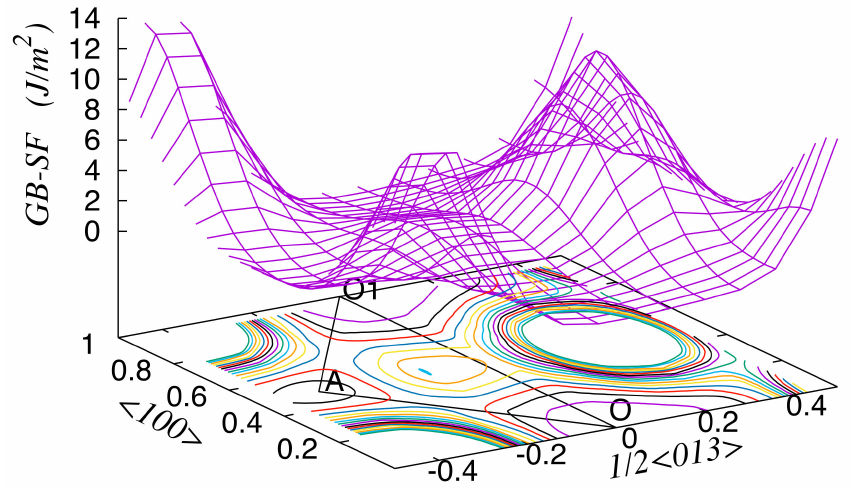
Figure 3. Unrelaxed GB–staking fault (SF) energy for the Σ 5{013} <100> GB in Al calculated by the molecular dynamics (MD) method